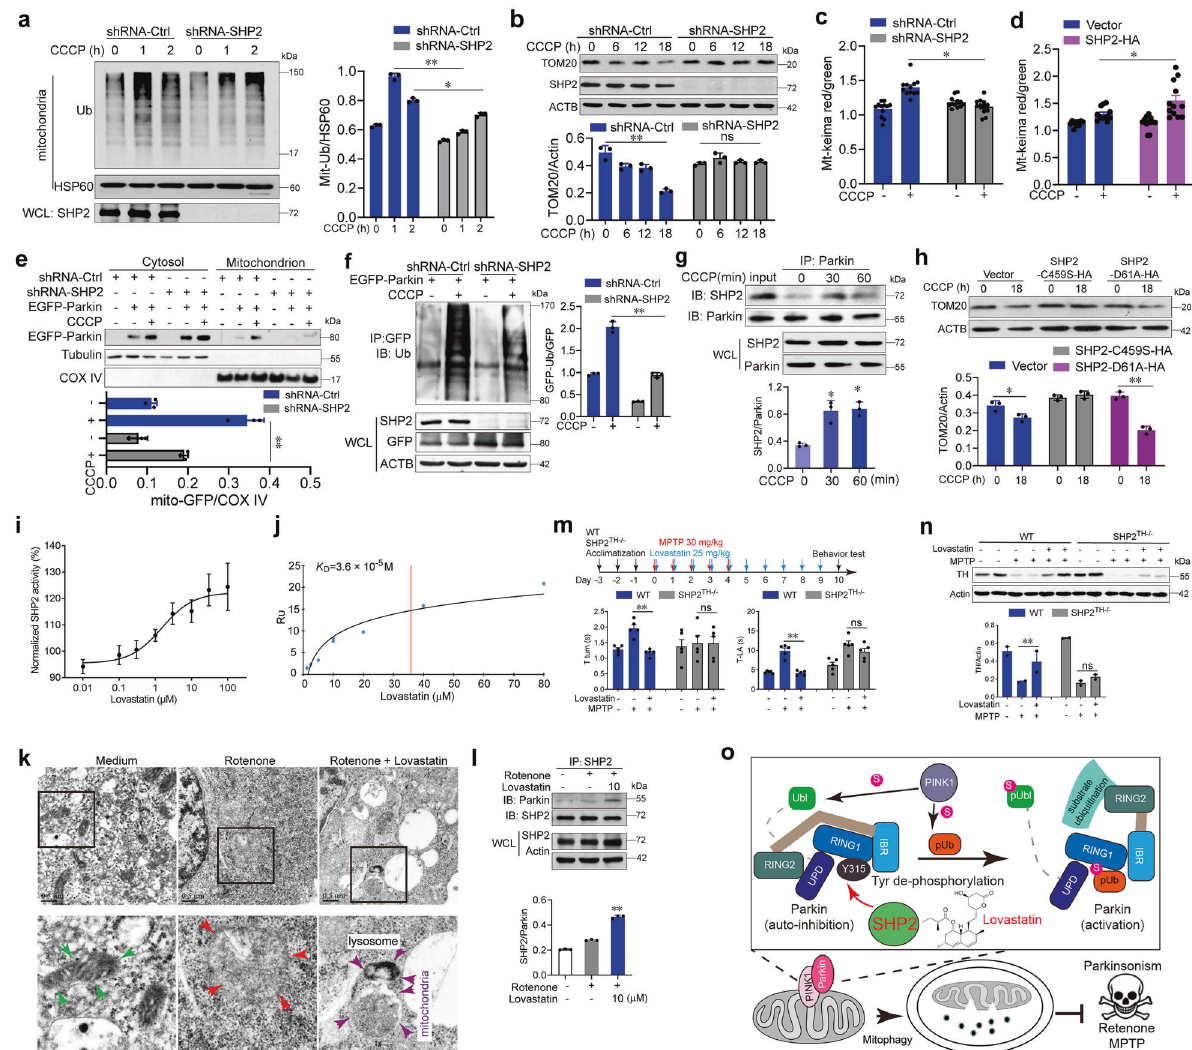
Fig. 1 SHP2-mediated mitophagy enhanced by lovastatin in neuronal cells alleviates parkinsonism in mice. a Immunoblot analysis of the ubiquitination of mitochondria in shRNA-SHP2 or shRNA-Ctrl SH-SY5Y cells treated with 10 μ M CCCP for indicated times. b Immunoblot analysis of TOM20 degradation in shRNA-SHP2 or shRNA-Ctrl SH-SY5Y cells in the presence of 10 μ M CCCP for indicated times. c , d Quanti fi cation of mt-Keima (red/green) in SH-SY5Y cells with SHP2 knockdown or overexpression. The cells were treated with 10 μ M CCCP for 1 h and then imaged with 458 nm (green) or 543 nm (red) light excitation. e Immunoblot analysis of Parkin ’ s mitochondrial translocation in shRNA-SHP2 or shRNA-Ctrl SH-SY5Y cells transfected with EGFP-Parkin for 24 h in the presence of 10 μ M CCCP for 1 h. f Immunoblot analysis of Parkin ubiquitination in HeLa cells co-transfected with shRNA-SHP2 and EGFP-Parkin for 24 h followed by 10 μ M CCCP treatment for 1 h. g Co- immunoprecipitation (Co-IP) analysis for the interaction of SHP2 with Parkin in SH-SY5Y cells treated with 10 μ M CCCP for indicated times. h Immunoblot analysis of TOM20 expression from SH-SY5Y cells transfected with vector or SHP2-C459S or SHP2-D61A as indicated in the presence of 10 μ M CCCP for 18 h. i The puri fi ed SHP2 protein was incubated with different doses of lovastatin and then the SHP2 enzyme activity was examined. j Interaction between lovastatin and SHP2 was determined via SPR analysis. k SH-SY5Y cells were pretreated with 10 μ M lovastatin for 3 h followed by the addition of 30 μ M rotenone for 6 h. Cells were collected for transmission electron microscopy assay. Green arrow, normal mitochondria; red arrow, swollen mitochondria; purple arrow, the damaged mitochondria localized near a lysosome in the autophagolysosome. l Co-IP analysis of Parkin and SHP2 in SH-SY5Y cells pretreated with 10 μ M lovastatin for 3 h followed by the addition of 30 μ M rotenone for 6 h. m Overview of the experimental design and behavioral tests for WT and SHP2 TH − / − mice treated with MPTP and lovastatin. n The expressions of TH in the striatum of each group were measured using Western blot analysis. o The graphic illustration of the mechanism of lovastatin-driven SHP2-mediated dephosphorylation of Parkin in promoting mitophagy in neuronal cells and alleviating parkinsonism in mice. Upon the initiation of mitochondrial damage in SH-SY5Y neuronal cells, SHP2 translocates to mitochondria, where it directly interacts with Parkin and promotes its E3 ligase activity via decreasing Parkin phosphorylation, increasing mitophagy as well as neuronal cell survival. Lovastatin promotes SHP2/Parkin-mediated mitophagy and exerts neuroprotective effects in MPTP-challenged mice. Data are representative of three independent experiments (mean ± SEM). * P < 0.05, ** P < 0.01 vs.